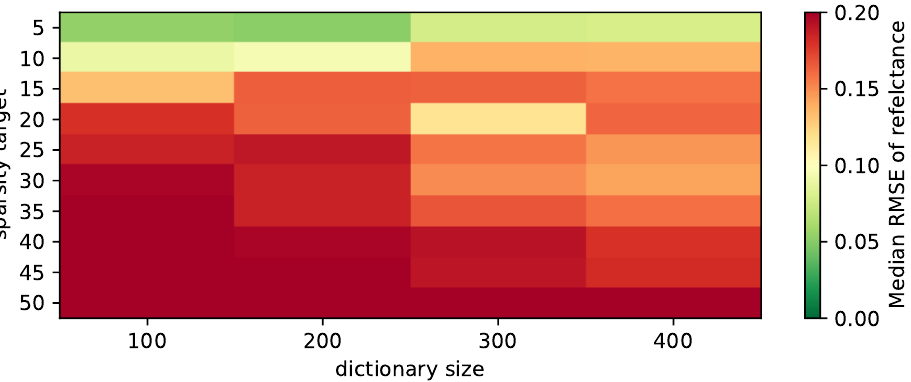
Figure 2. Impact of different dictionary sizes and sparsity targets on reconstruction quality. Curiously, the result drastically differs from that in [4]: the error increases when in- creasing the sparsity target. Increasing the dictionary size only increases reconstruction for higher sparsity targets. However, as the previous effect is stronger, best results are therefore achieved with small dictionary and low sparsity target. We attribute this to the spectra varying less across pixels because of the comparably low resolution in remote sensing, which leads to averaging out special spectra, and because of the relatively homogeneous agricultural environment.